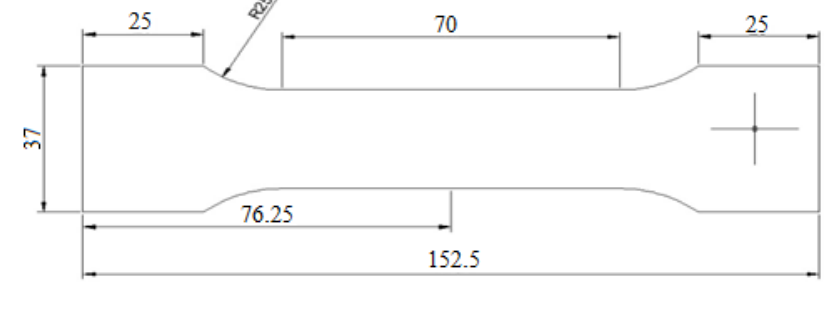
Figure 1. Tensile test sample.